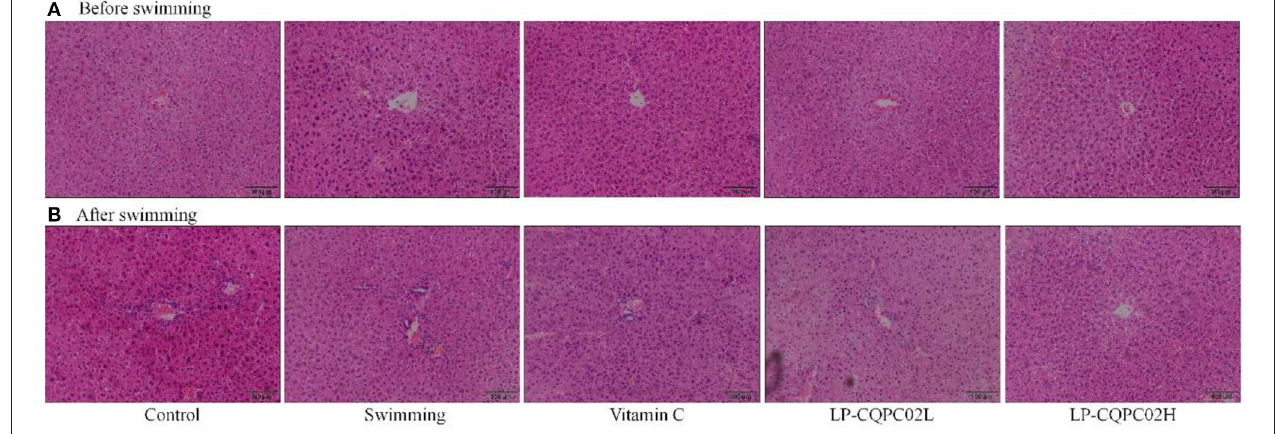
FIGURE 2 | Pathological observation of hepatic tissue H&E section of (A) before swimming and (B) after swimming mouse in each